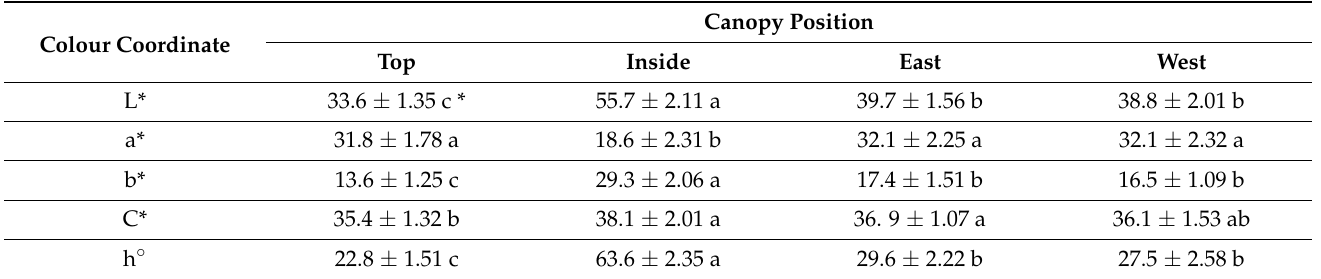
Table 3. Effect of canopy position on fruit colour pattern according to CIE L*a*b* colour space coordinates, average